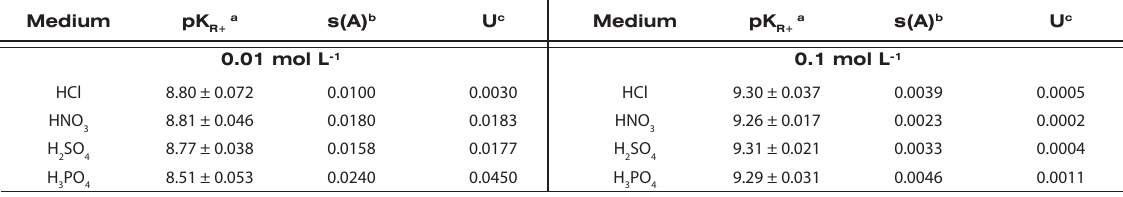
= 6.5 µmol L -1 , CHE